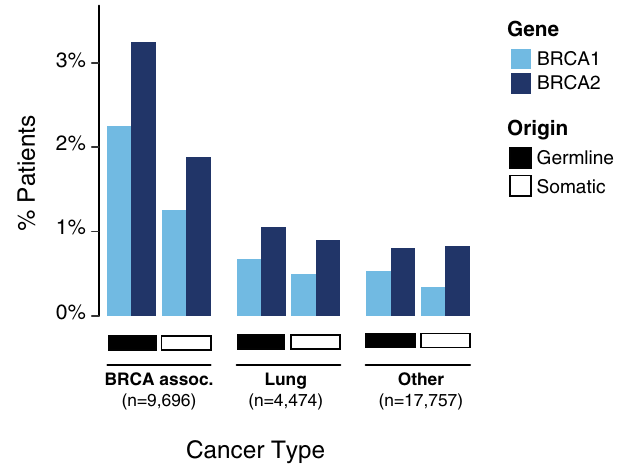
Fig. 1 | BRCA1/2 alteration frequency in MSK-IMPACT. Percentage of patients withsomaticandgermline BRCA1 and BRCA2 alterationsamongpatientswith BRCA- associated cancers (breast, ovarian, pancreas and prostate, n =9696), lung ( n =4474), and other cancer types ( n =17,757, see Supplementary Data 1 for breakdown of other